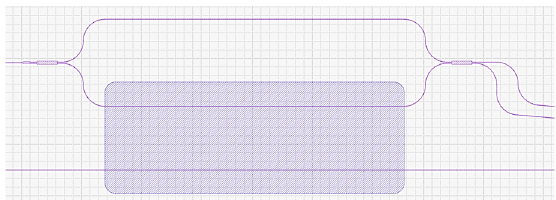
Figure 2. The tested MZI structure with multimode interference (MMI) in and out coupling. The LC is located in the dashed area. The straight line at the bottom is another waveguide that is not employed in this setup.